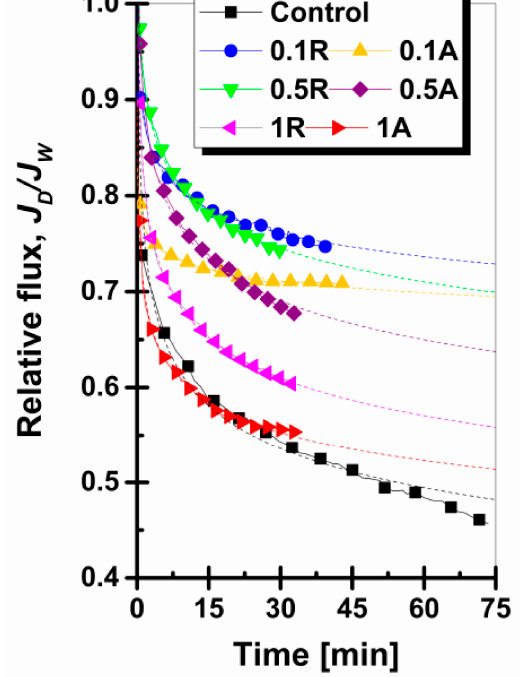
Figure 9. Study of membrane fouling using the relative flux method for the control membrane and the membranes with the addition of TiO 2 nanoparticles, rutile and anatase phases (Note: dashed lines represent the allometric non-linear curve fittings of the relative fluxes).